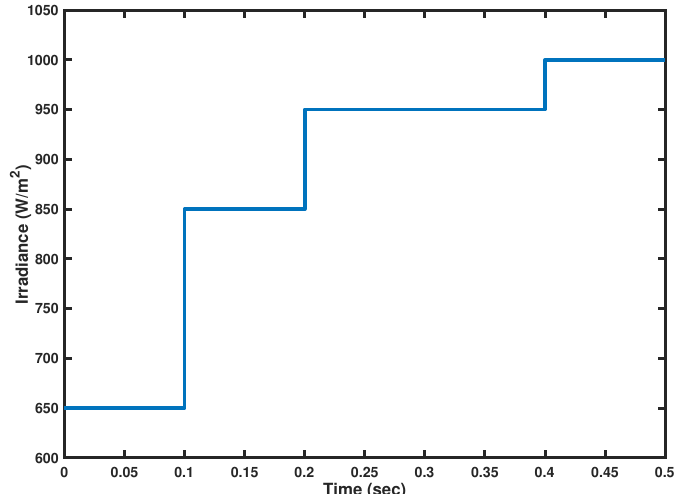
Figure 11. Varying levels of